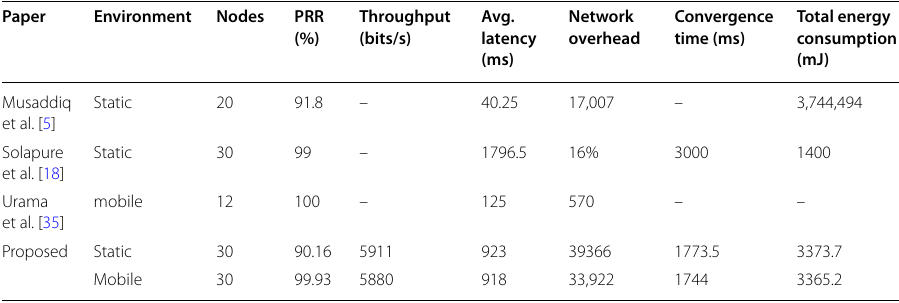
Table 3 Comparison of performance